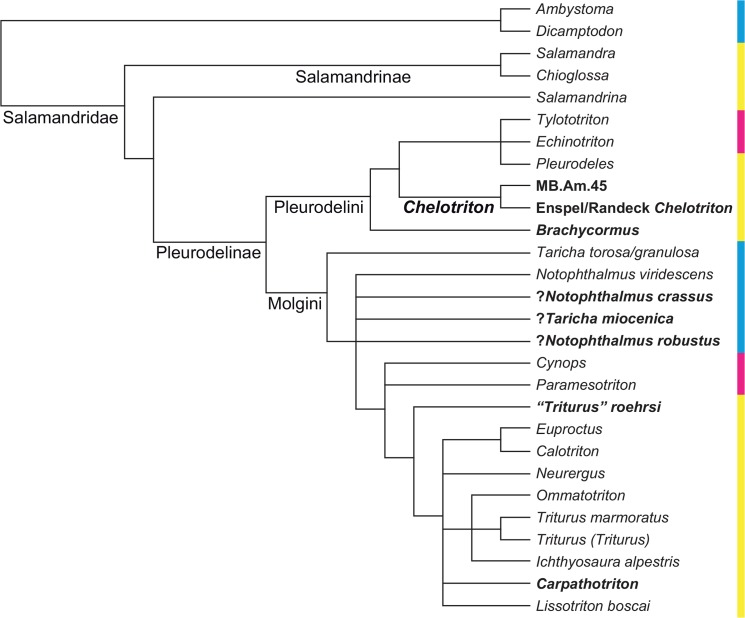
Strict consensus of the pruned most parsimonious trees from our unconstrained analysis that includes geographic distribution as character 98 (length of individual trees before pruning = 603 steps).
Archaeotriton, Koalliella,? Ichthyosaura randeckensis, Pachytriton, Lissotriton vulgaris, L. montandoni, L. italicus and L. helveticus were pruned from all trees before calculating their strict consensus, but were included in the phylogenetic analysis that generated the trees. Names of extinct taxa are in boldface. Colors as in Fig 1.